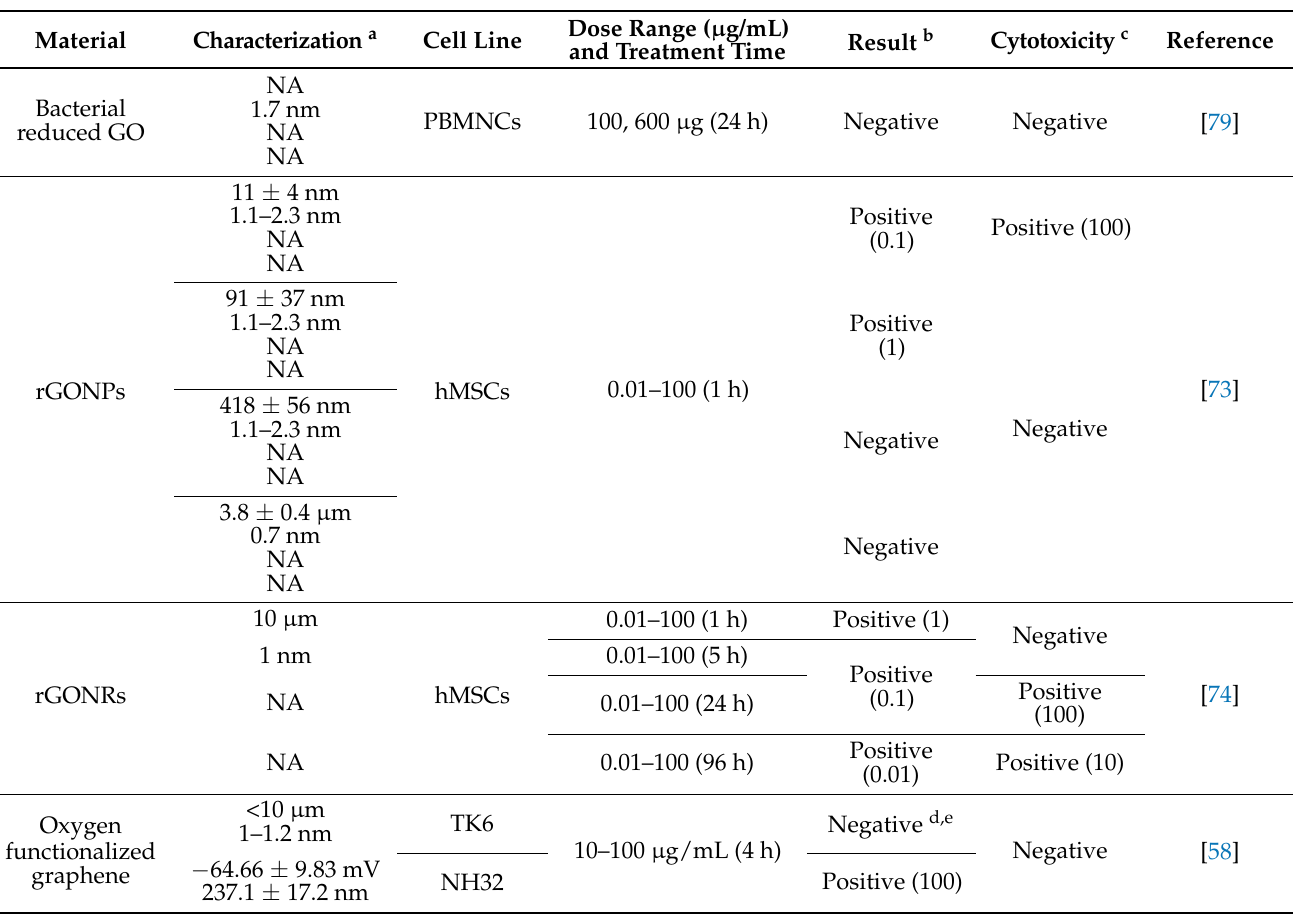
Table 2. In vitro studies assessing the genotoxicity of GBMs using the chromosome aberration